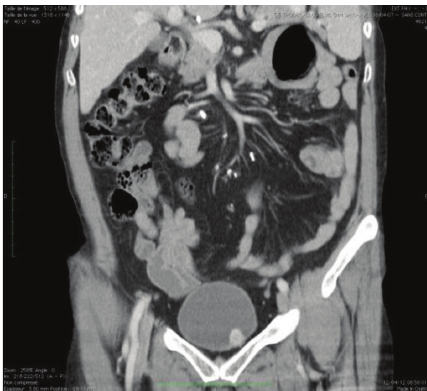
Figure 1: CT scan showing small tumour located in the anterior front of the bladder with well-defined bounds and increasing its density after the injection of iodine-containing contrast solution.